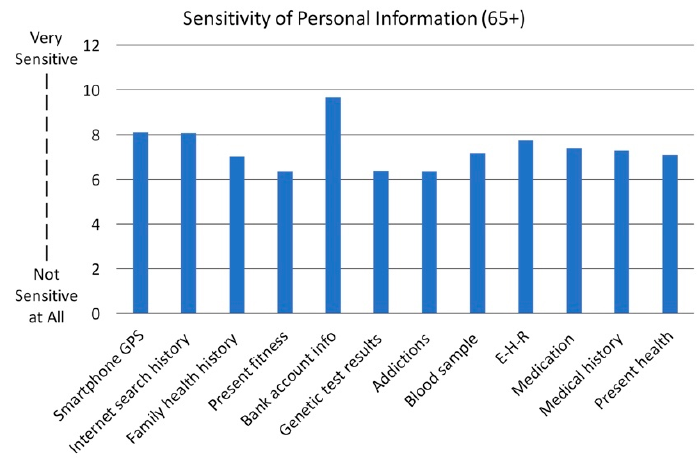
Figure 4. Sensitivity of Personal Information Analysis.